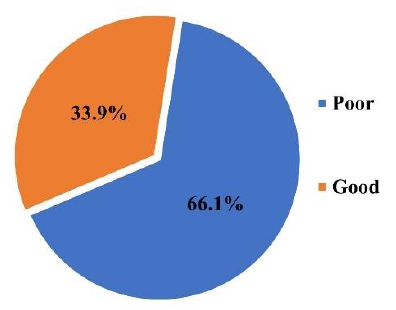
Figure 1. The percentage of poor and good adherence to the HEP by the mothers of C-CP.